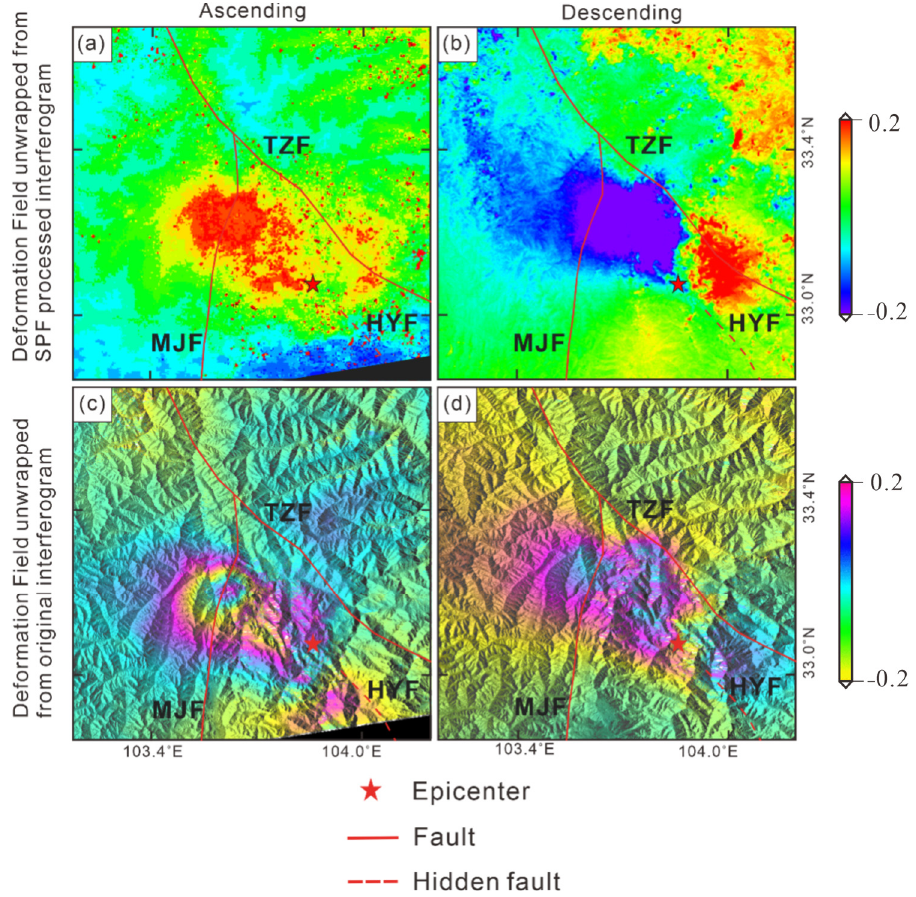
Figure 9. The comparison between the deformation field unwrapped from original interferogram and from SPF enhanced interferogram. Panels ( a , b ) represent the deformation fields unwrapped from the SPF enhanced interferogram along ascending and descending orbits, respectively; ( c , d ) represent the deformation fields unwrapped from original interferogram along ascending and descending orbits, respectively.